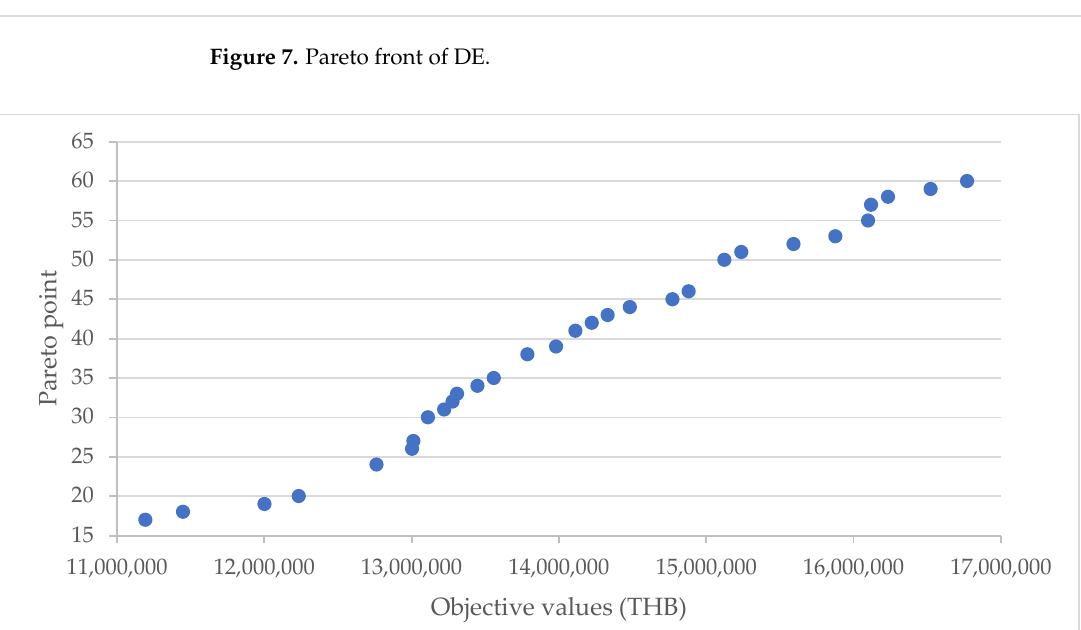
Figure 8. Pareto front of GA.